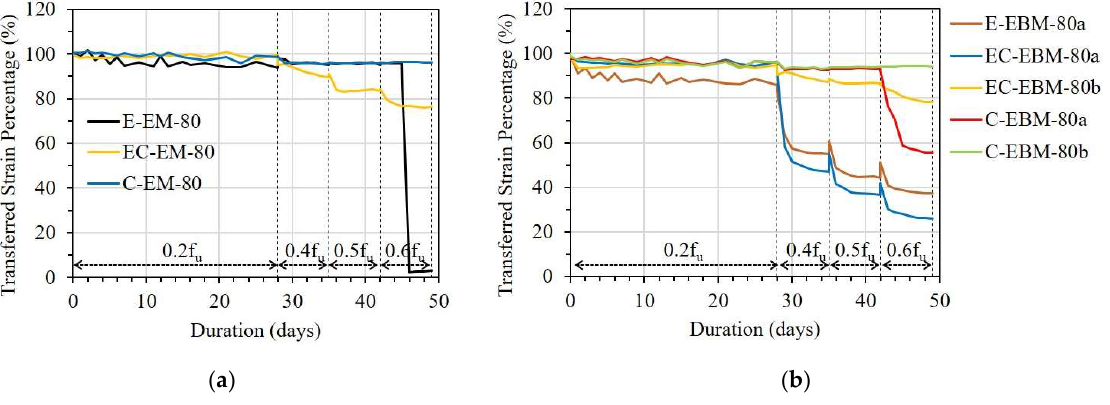
Figure 19. Short-term creep effect on shear transfer with different types of adhesives: ( a ) EM with bond length of 80 mm and ( b ) EBM with bond length of 80 mm.